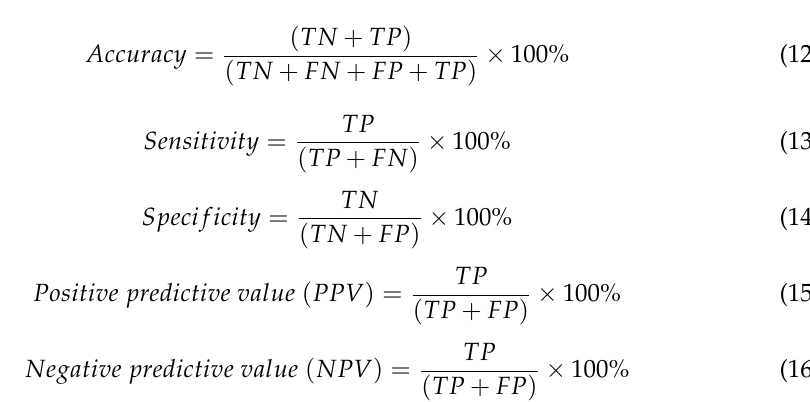
Table 3. LeNet with the SGD optimizer achieved a 95.92% accuracy, which is higher than